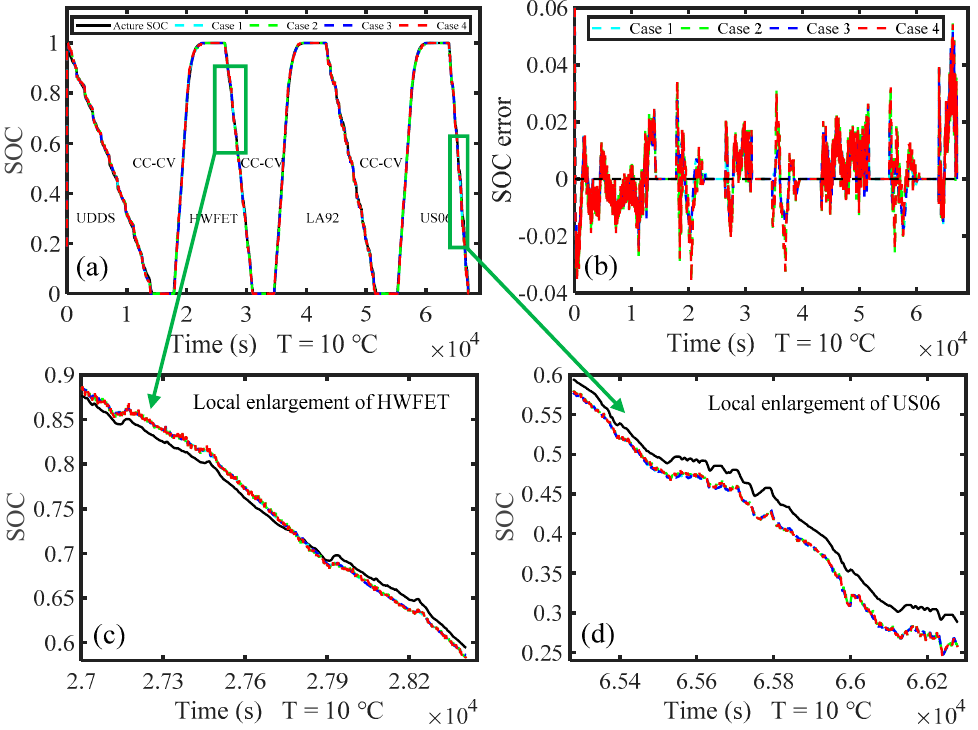
Figure 10. SOC and SOC error of GRU-ATL model in four cases at 10 °C: ( a ) SOC, ( b ) SOC error, ( c ) local enlargement of HWFET, ( d ) local enlargement of US06.